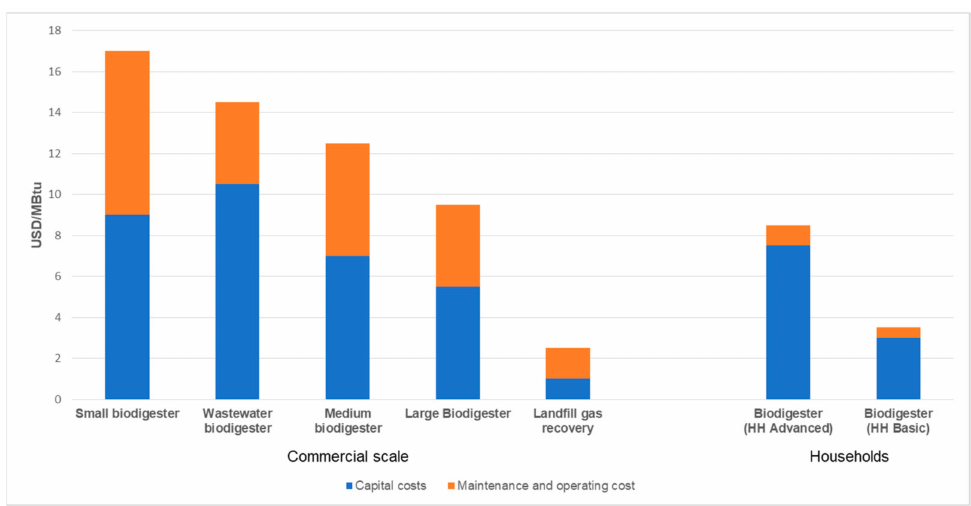
Figure 11. Investment and maintenance costs for biogas production technology per unit of energy produced in 2018. HH = household; “HH Advanced” includes pre-manufactured biodigesters made of more expensive composite material; “HH Basic” includes biodigesters constructed in place using traditional construction materials such as sand, gravel and cement. Adapted from